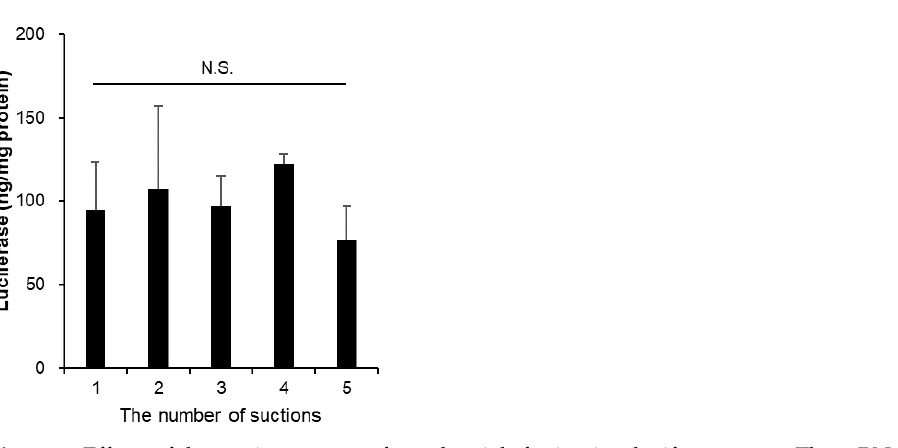
Figure 5. Effects of the suction pressure from the vials for in vitro luciferase assay. The mRNA-LNPs